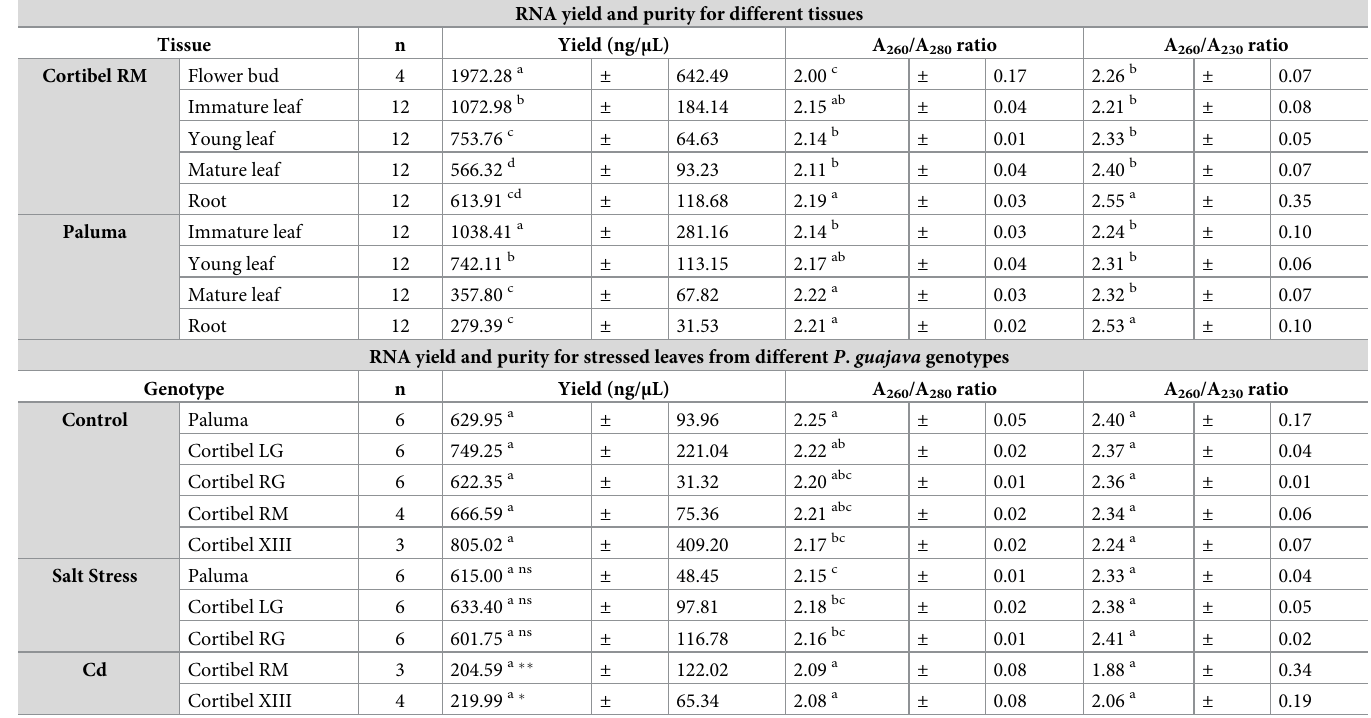
Table 3. Analysis of RNA yield and purity using CTAB 2 method.